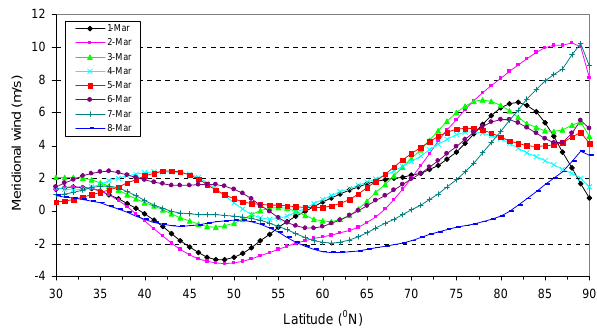
Fig. 9 Fig. 9. Zonal-mean daily meridional wind v (ms − 1 ) at 500 hPa ( ∼ 5500m), averaged over longitude 1–90 ◦ E during 1–8 March 1999. v> 0 denotes southerly wind and < 0 denotes northerly wind.